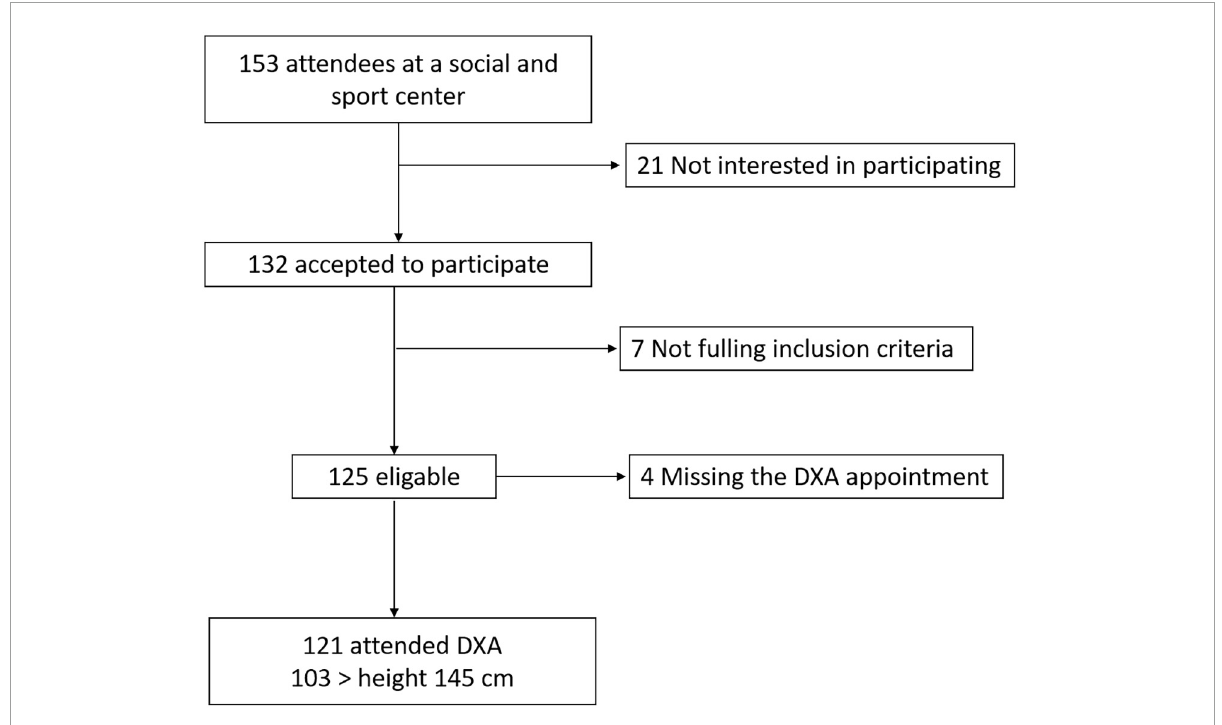
FIGURE1 Flow chart of participant recruitment.